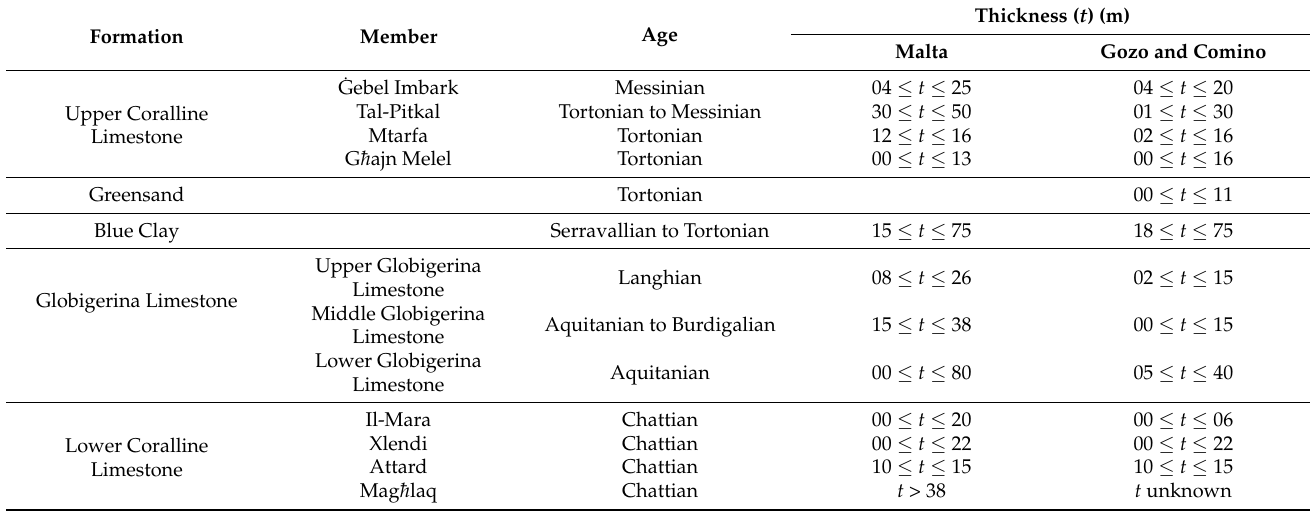
Table 1. The lithostratigraphy of the Maltese Archipelago